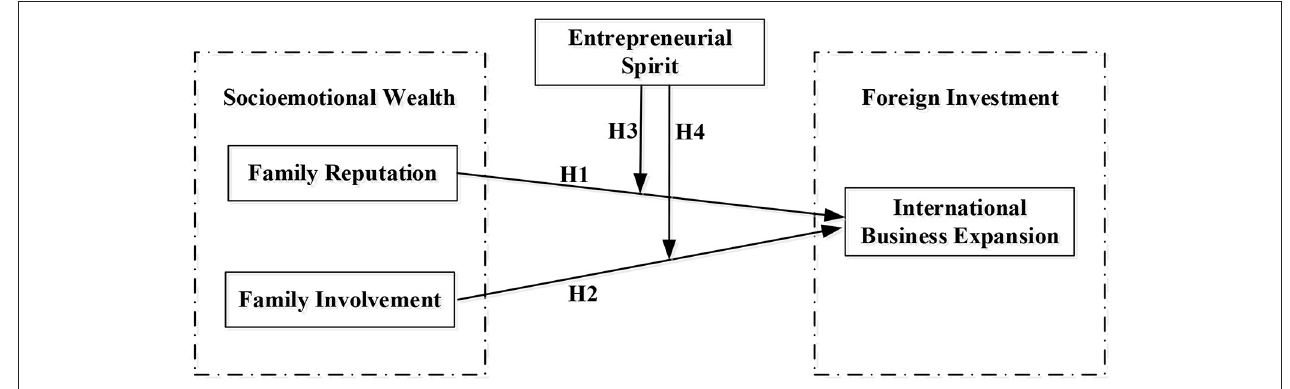
FIGURE 1 | Conception